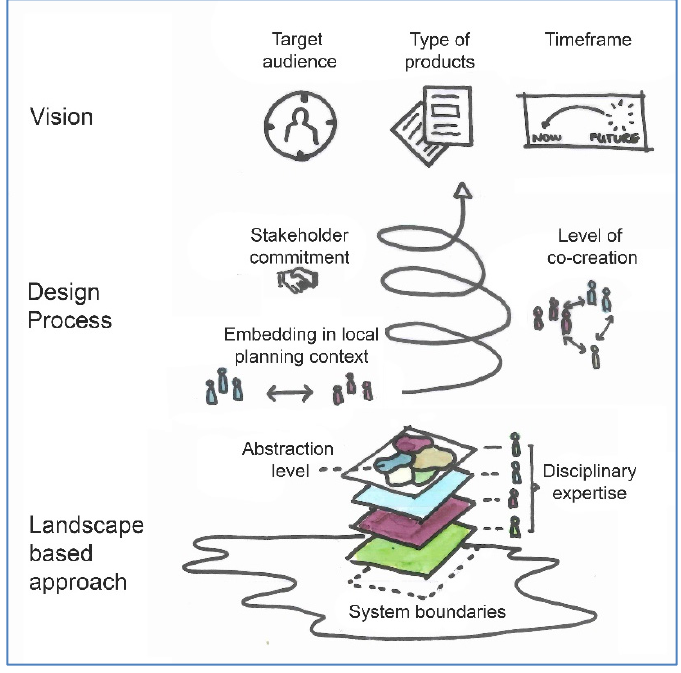
Figure 6. Key aspects of the visioning process.